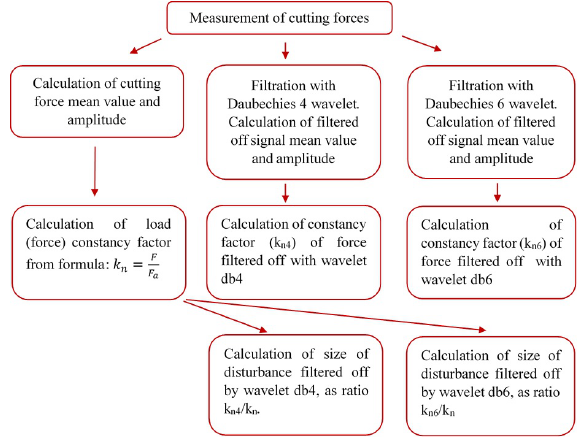
Figure 6. Cutting force analysis procedure.